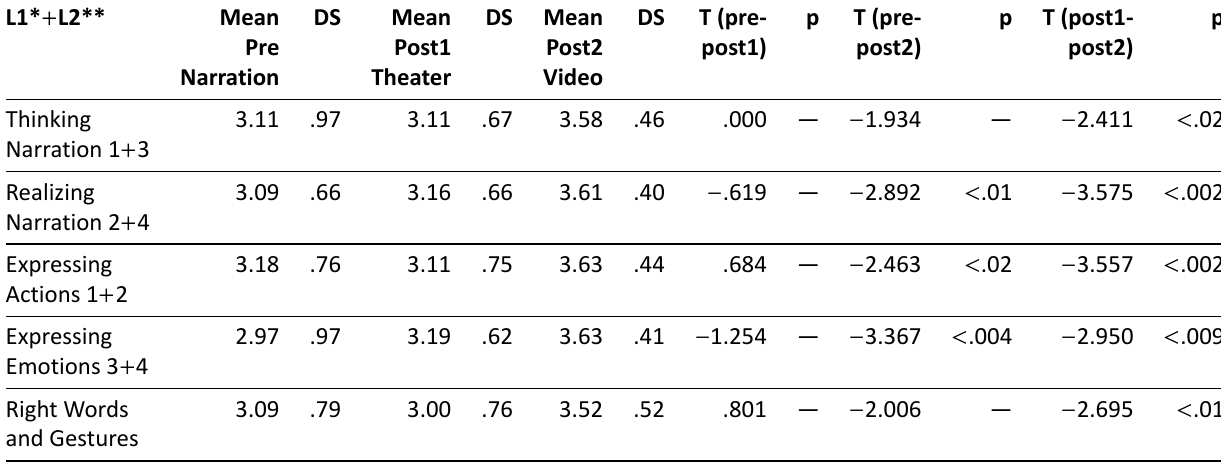
Table 1. Pre-test, post-test 1 theater and post-test 2 video: means, standard deviations and results of t-test for self-efficacy divided by categories for all children.